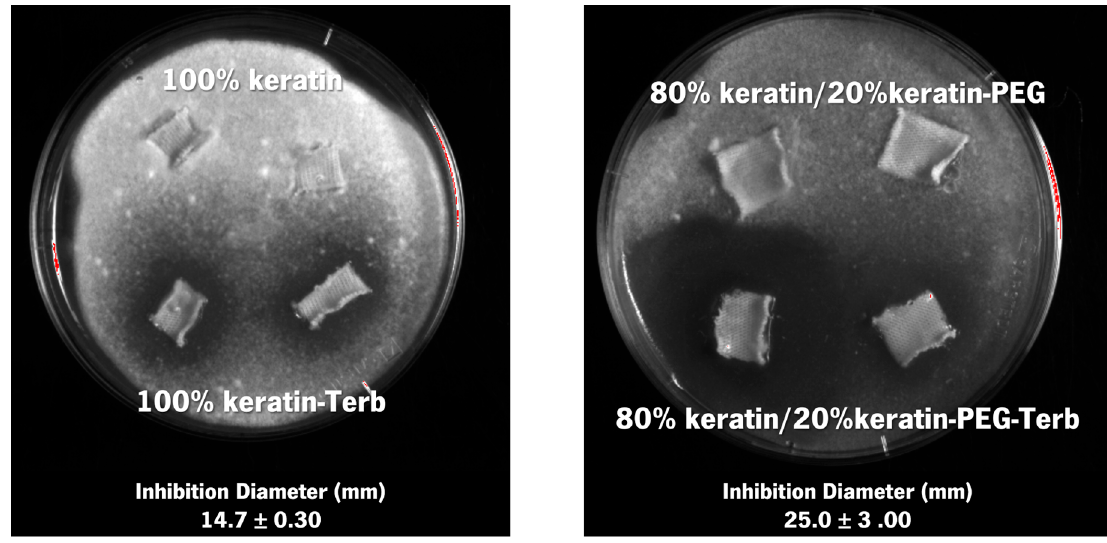
Figure 9. Antifungal activity of the functionalized fabrics (100% keratin; 100% keratin-Terb; 80% keratin/20% keratin-PEG; 80% keratin/20% keratin-PEG-Terb) against Trichophyton rubrum .